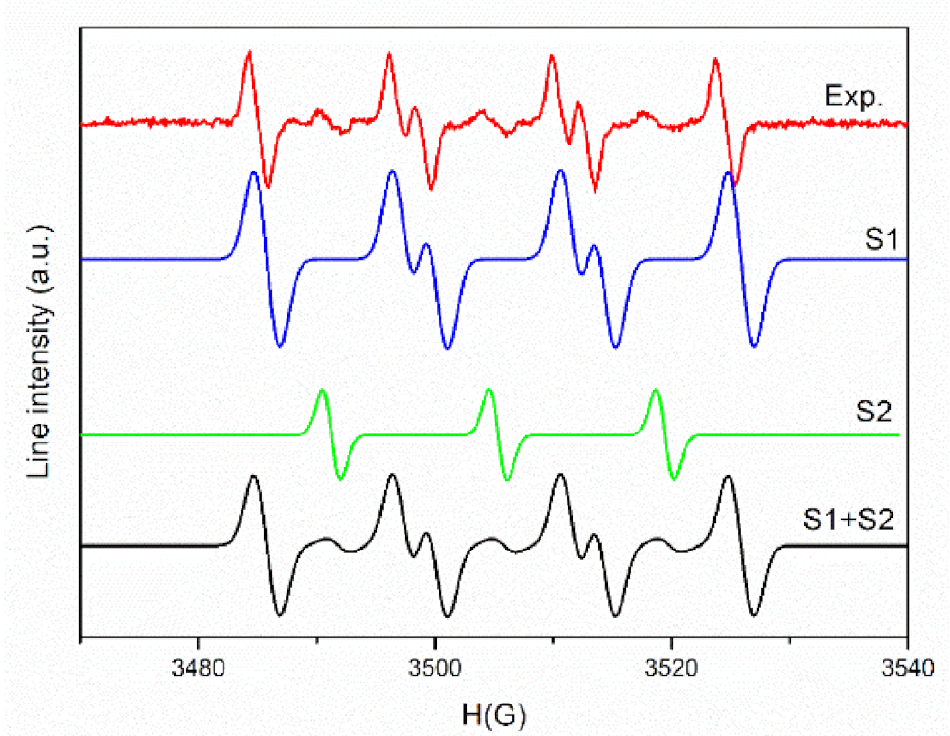
Figure 9. The experimental and simulated spectra of PLA/PHBV/ZnO:Fe0.3% in DMSO suspension in the presence of